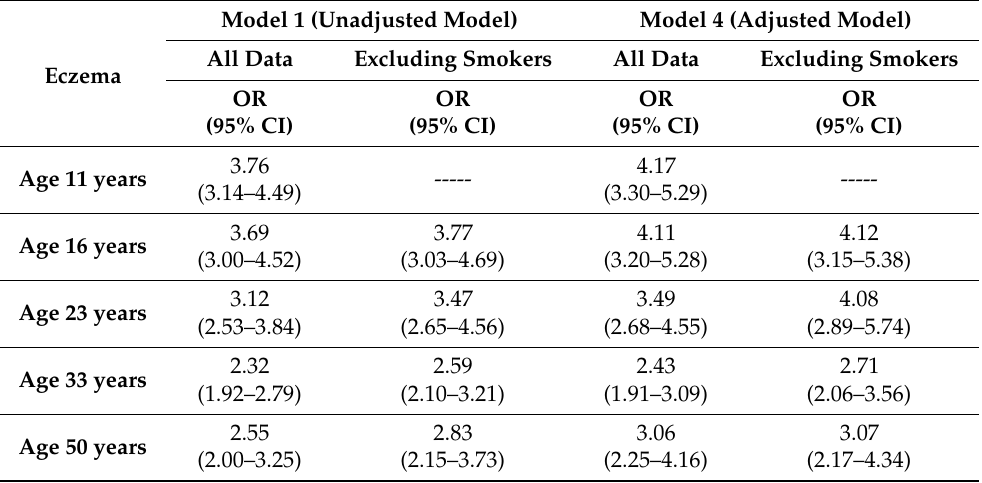
Table 2. Association between asthma and childhood eczema, adjusting for sex, socioeconomic status (SES), parental smoking, mother smoking status after month four of pregnancy, birth weight of subject, and mother’s weight at pregnancy period for ages 11, 16, 23, 33, and 50 years in the 1958BC study. The analysis was repeated after excluding the participants who smoked tobacco during the study.